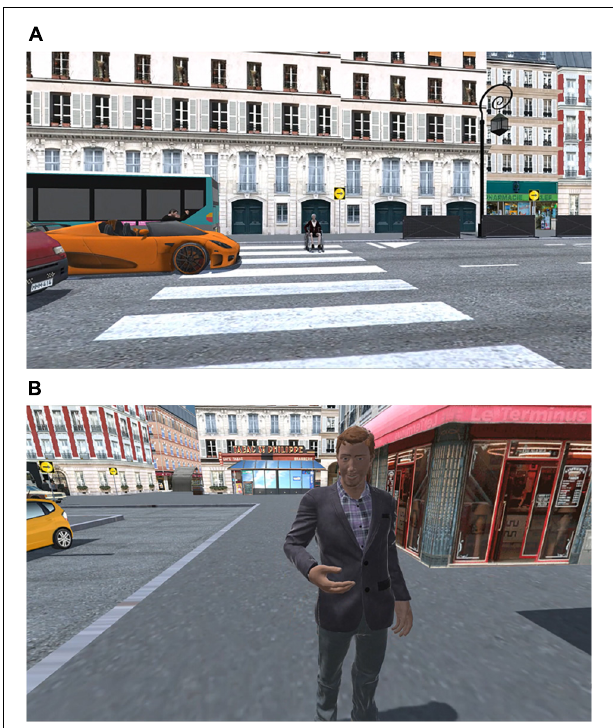
FIGURE 1 | Example of social situations encountered in the virtual environment: (A) Conventional transgression (a driver honking a woman in a wheelchair); (B) control situation (a man asking the participant the time).